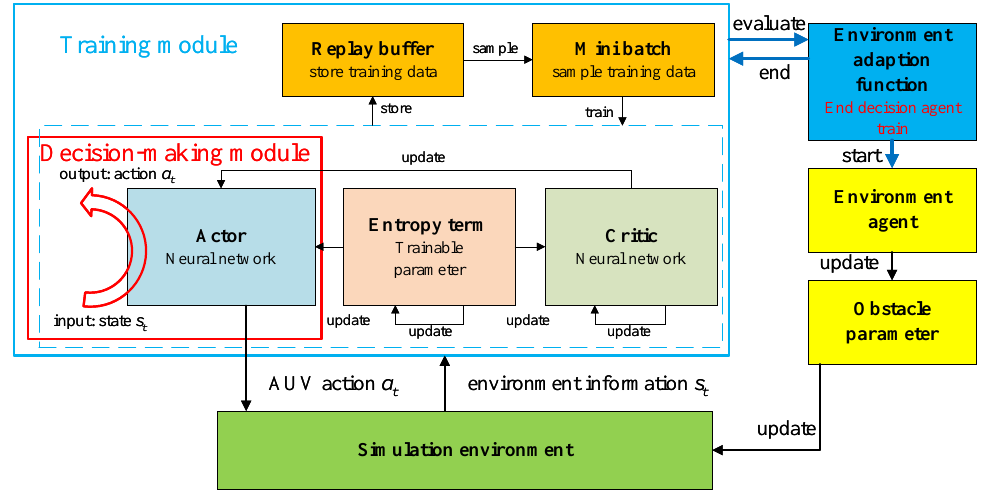
Figure 4. Decision agent